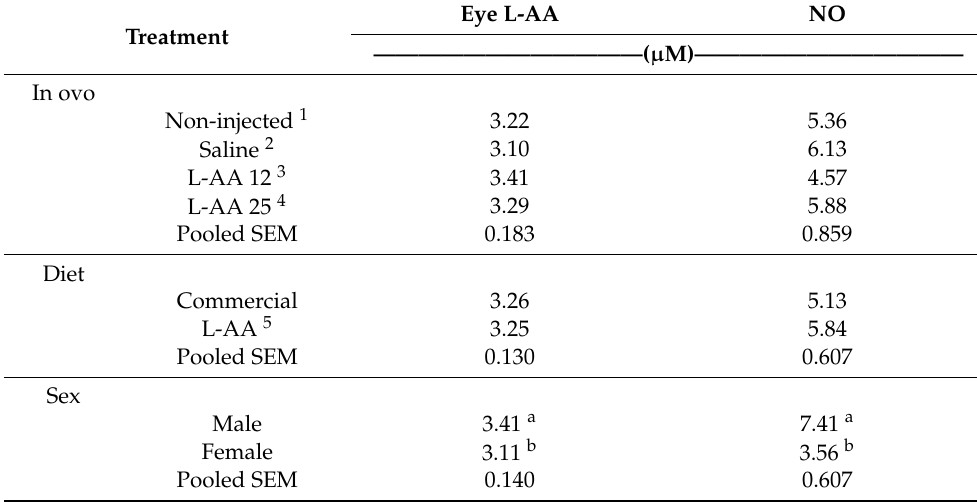
Table 7. Effects of treatment non-injected; saline-injected (saline); saline containing 12 mg of L- ascorbic acid (L-AA 12), or 25 mg of L-ascorbic acid (L-AA 25) at 17 days of incubation (doi) and either a commercial diet or a diet supplemented with 200 mg/kg of L-AA on L-AA concentrations in the right eye (Eye L-AA) and nitric oxide (NO) concentrations in the plasma of male and female broilers at 14 days of post hatch